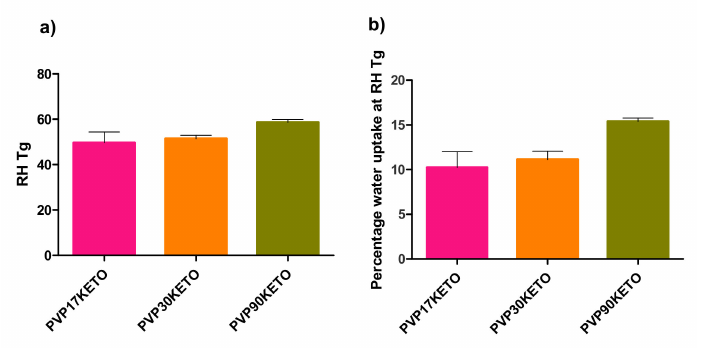
Figure 8. ( a ) The relative humidity at which a glass transition was induced for PVP–ketoprofen systems of di ff ering molecular weights. ( b ) The mass percentage of water uptake for PVP–ketoprofen systems at the relative humidity induced glass transition for di ff ering PVP molecular weights.